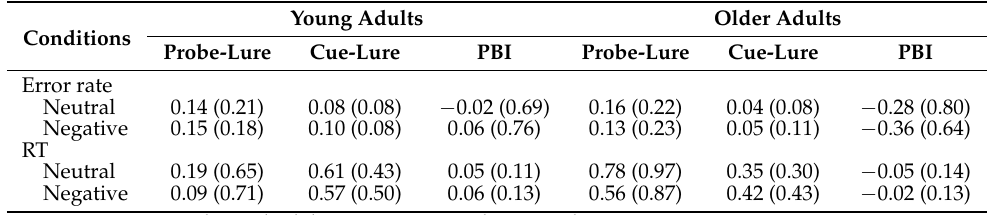
Table 2. Mean error rates and RT median z-scores of the critical cue-lure and probe-lure trials, as well as the PBI scores across age and mood conditions in Experiment